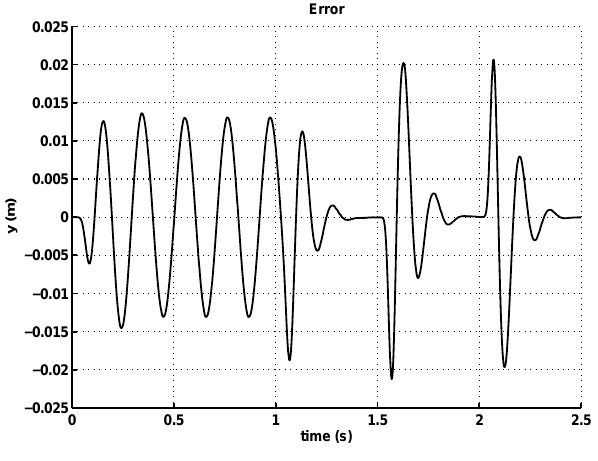
Figure 9: Tracking error for Fig. 8.